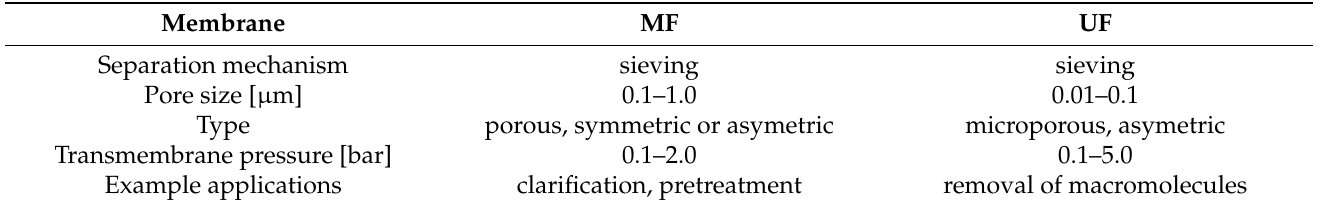
Table 1. The characteristics of MF and UF membranes used for the treatment of wastewaters in AnMBRs technology. Based on